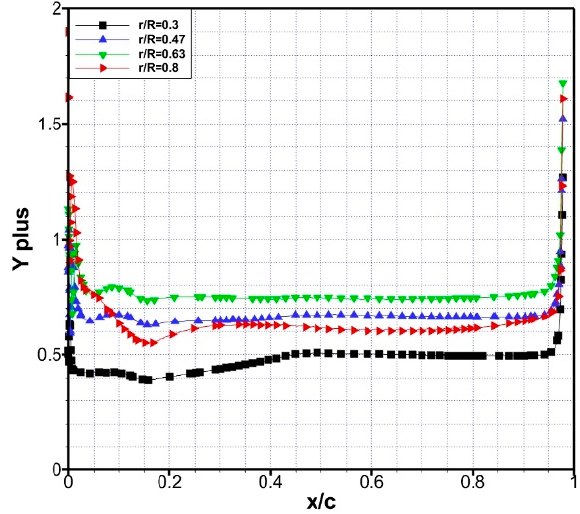
Figure 4. Y plus over the suction side at different spanwise sections for a wind speed of 19 m s − 1 . Table 2. Boundary conditions.